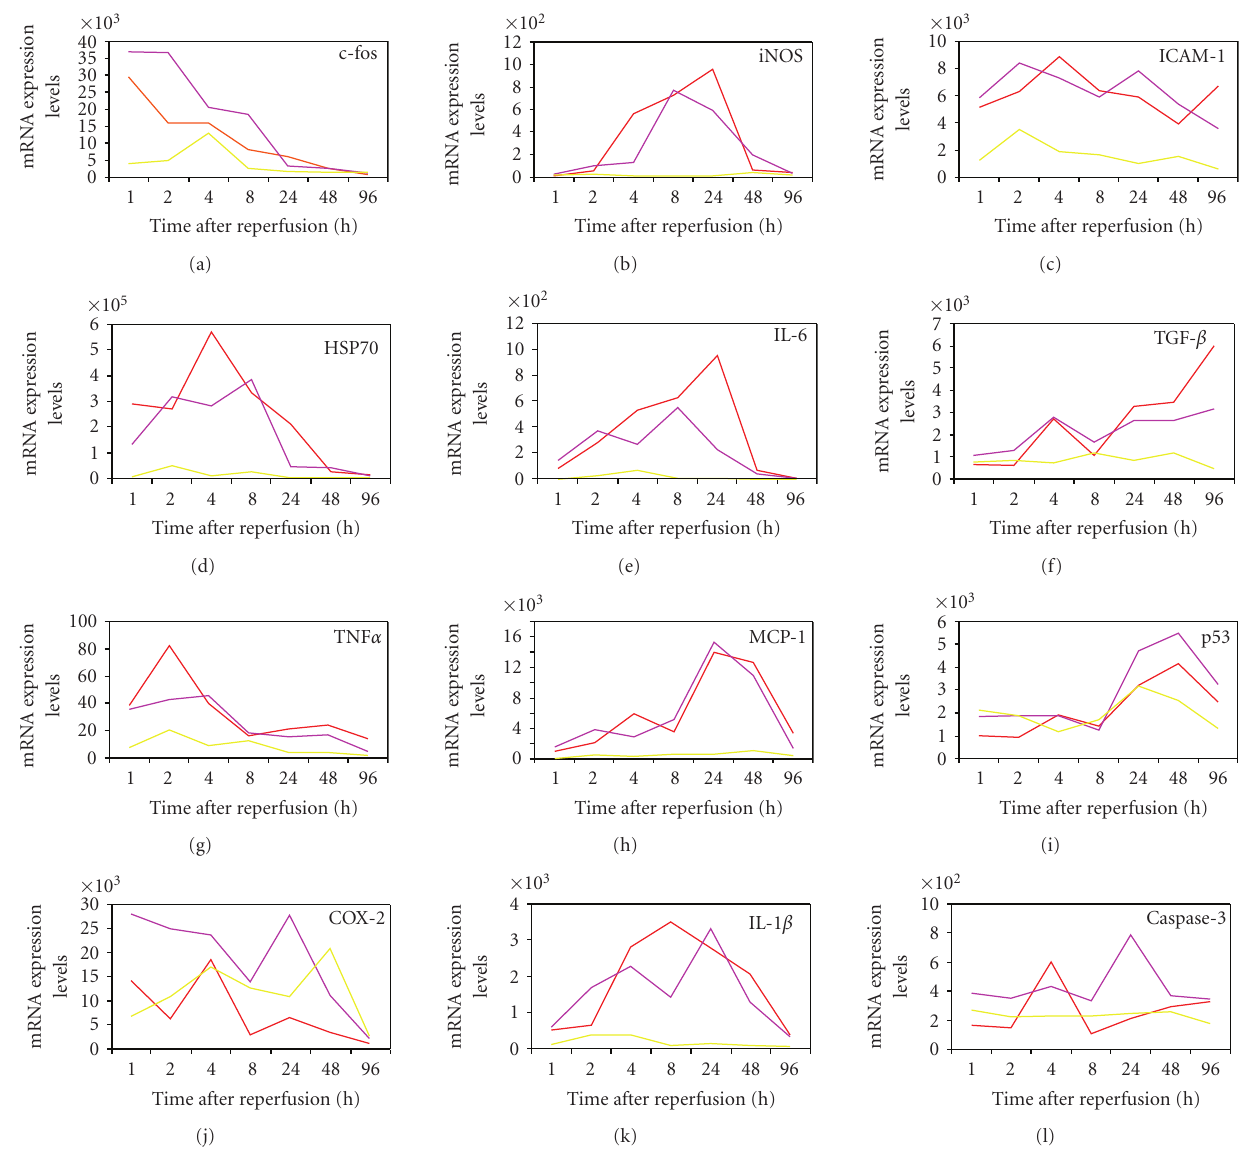
Figure 2: Stress-related genes expression in rat brains after reperfusion under normothermia. The expression levels of each mRNA in ischemic core (red), penumbra (purple), and normal (yellow) regions were quantified by real-time PCR, and their mRNA expression levels were shown as a gene copy number per 1ng of polyA + RNA. The procedure used has been previously described